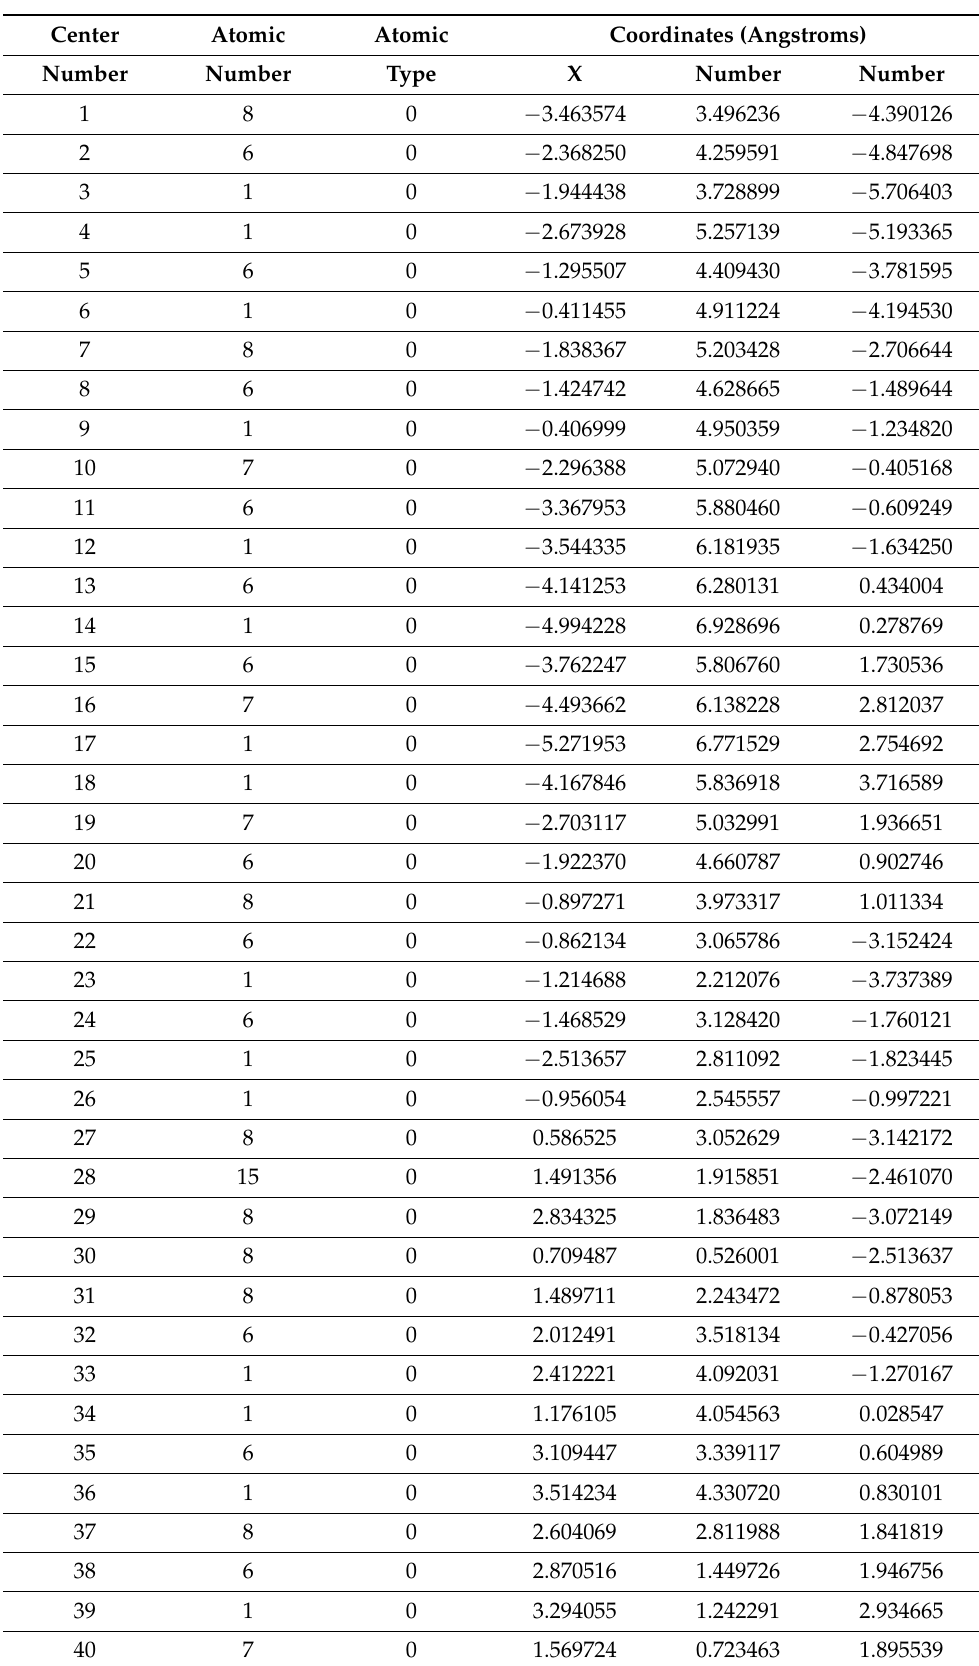
Table A19. Complex MgI 3 LiII 2 with nucleotide triplet